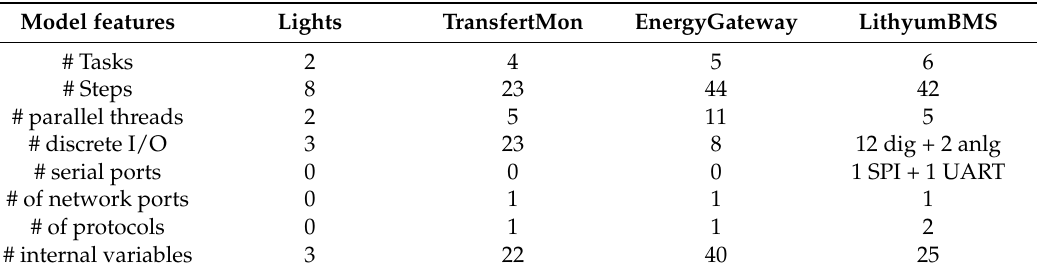
Table 2. Model-level characteristics of the different CPSs.